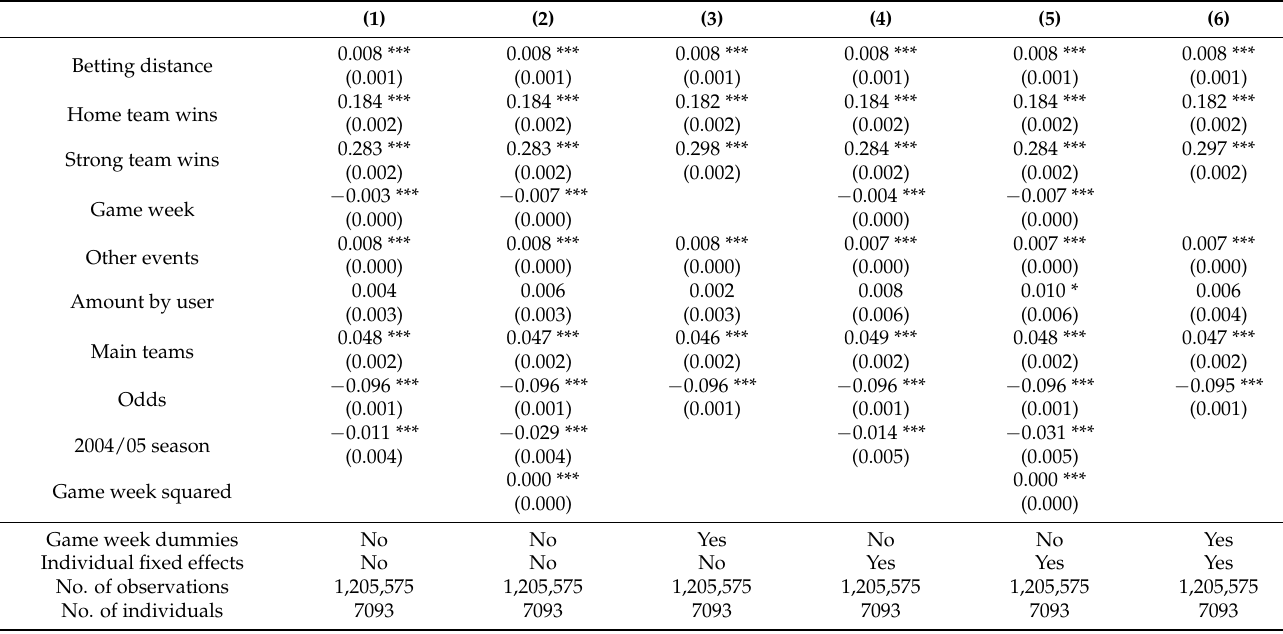
Table 3. The impact of betting distance: baseline specifications.